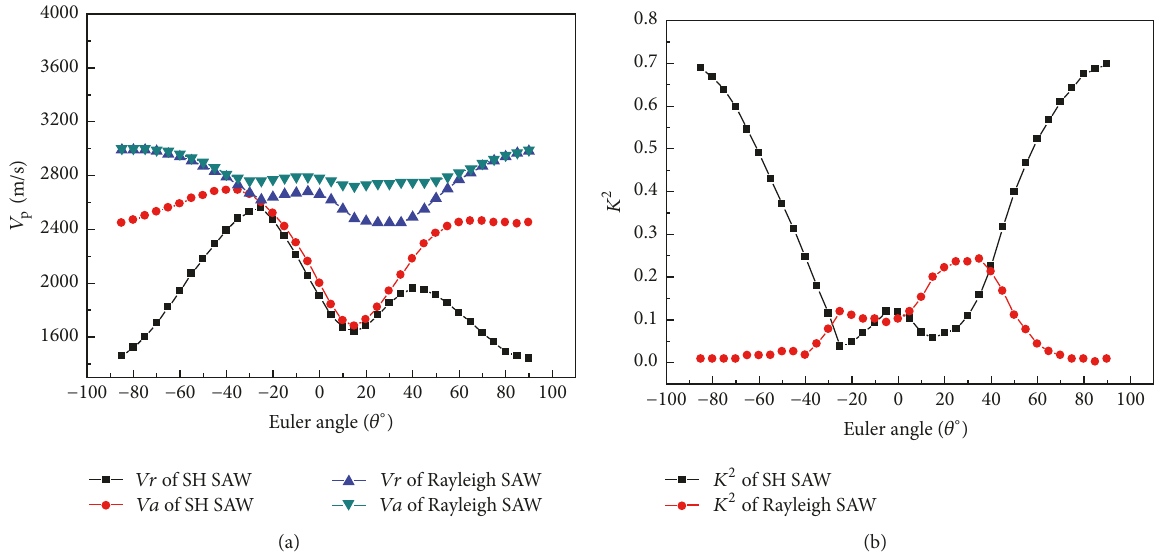
Figure 6: (a) Effective velocities and (b) estimated 𝐾 2 (as a function of 𝜃 from −90 ∘ to 90 ∘ ) of SH and Rayleigh SAWs.